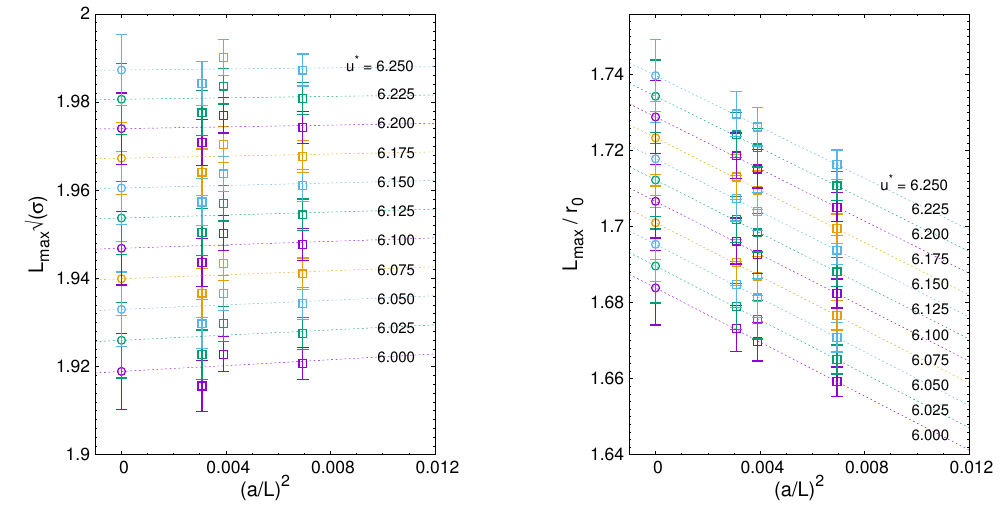
p (cid:27) (left) and L max =r 0 (right) for each u (cid:3) . The lines show